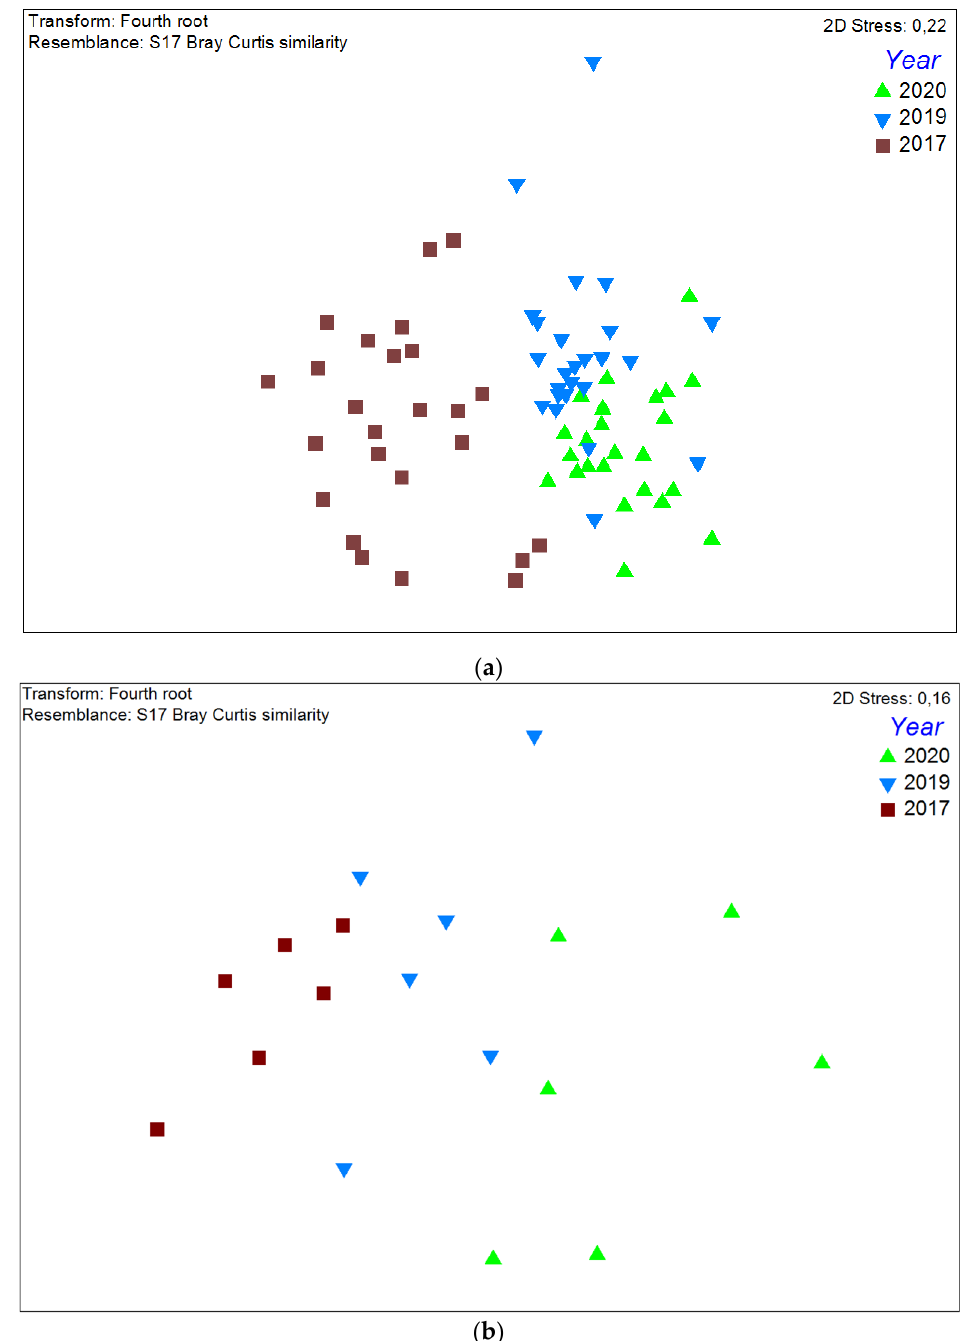
Figure 4. Non-metric multidimensional scaling (MDS) plots showing the similarities among the three sampling periods (indicated by different colors) between: ( a ) sessile communities and ( b ) motile communities.